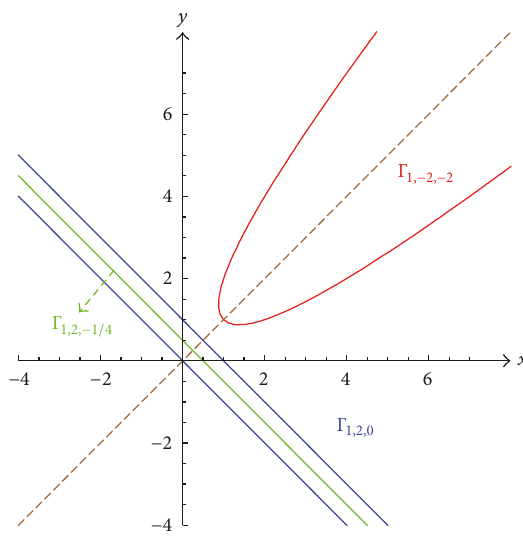
Figure 6: The parabolae with |𝜌| = 2